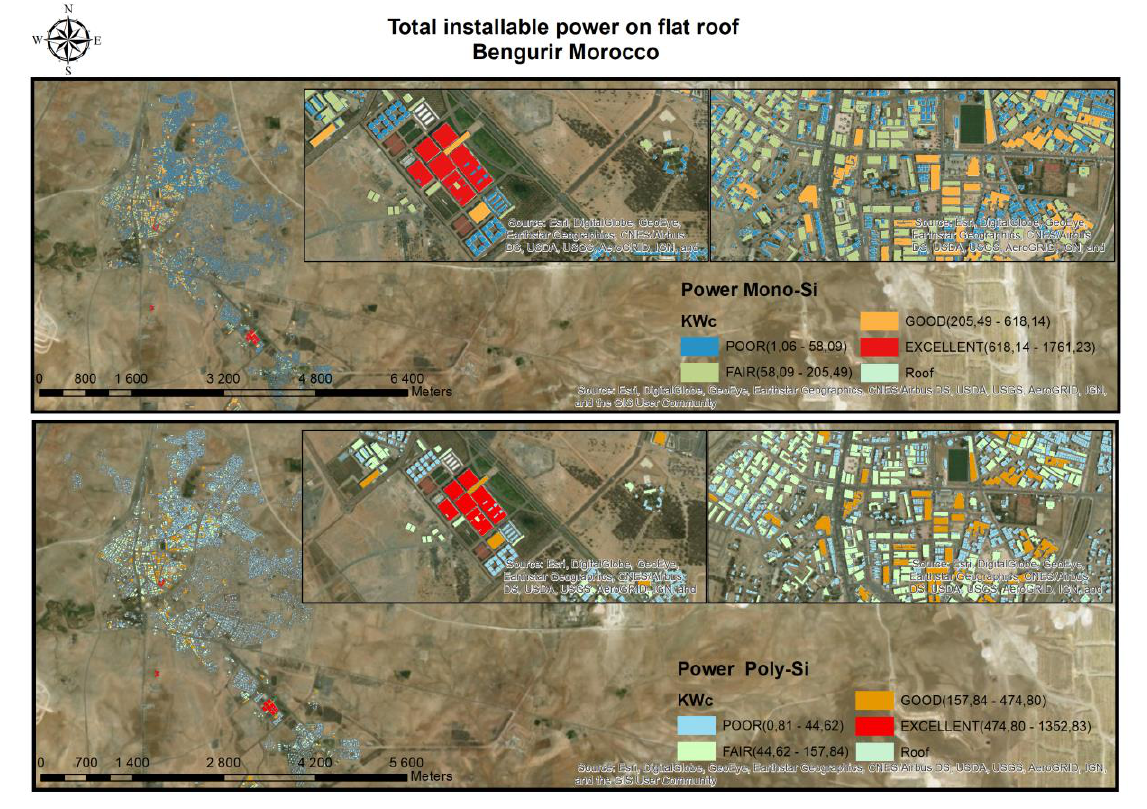
Figure 8. Total installable Power on flat